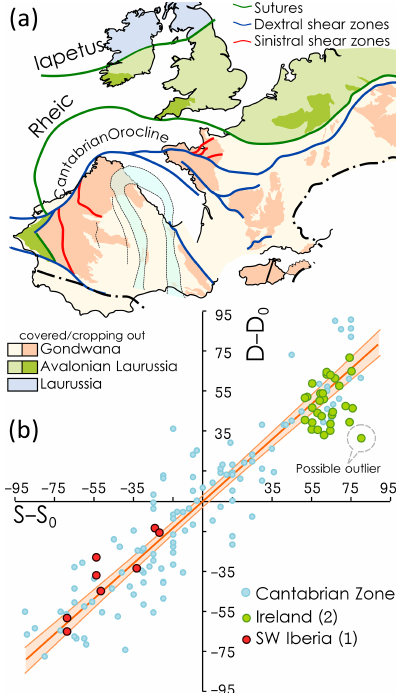
Figure 10. Orocline test of the Cantabrian Orocline (Weil et al., 2013) compared with the magnetization found in the adjacent Lau- russian segments of the orogen: Ireland (Pastor-Galán et al., 2015b) and the South Portuguese Zone (Leite Mendes et al.,